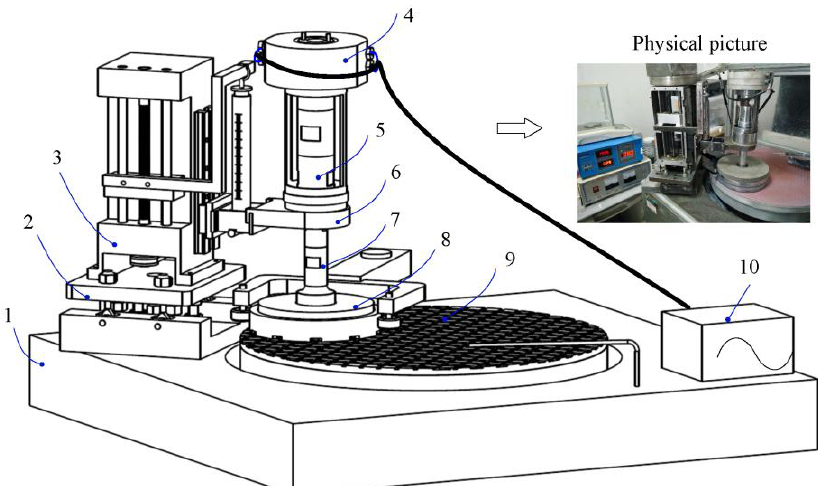
Figure 2. Structural diagram and physical picture of ultrasonic CMP system: ( 1 ) polisher (Bni62, Japan); ( 2 ) universal platform; ( 3 ) load adjuster; ( 4 ) sliding ring components; ( 5 ) transducer; ( 6 ) self-aligning ball bearing; ( 7 ) stepped horn; ( 8 ) retaining and dressing ring; ( 9 ) polishing pad; ( 10 ) ultrasonic digital power source.